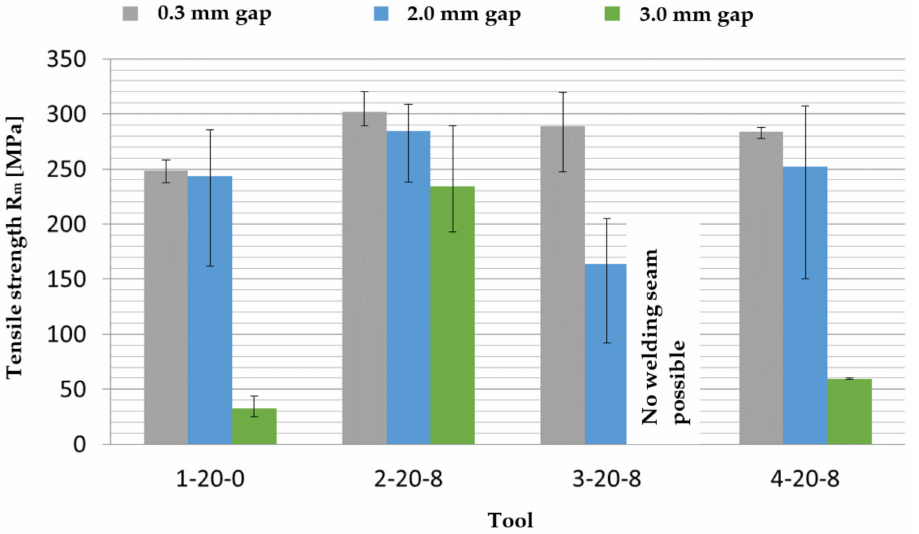
Figure 26. Tensile strengths of additional tests with joint gap widths up to 3 mm.